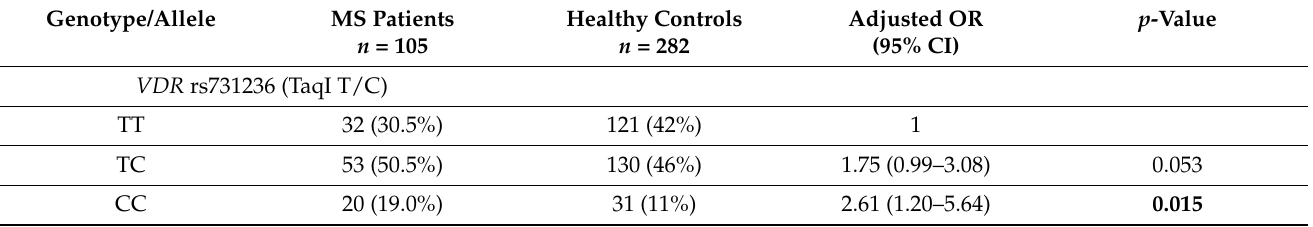
Table 3. VDR rs731236 (TaqI T/C) and VDR rs433408 (HpyCH4V G/A) genotypic and dominant association with MS using logistic models corrected by age and